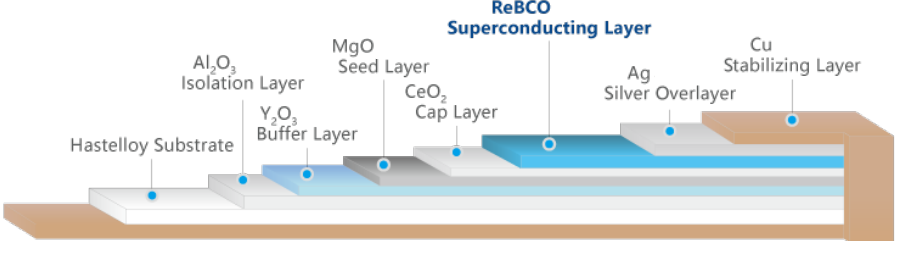
Figure 12. Structure diagram of YBCO tape.